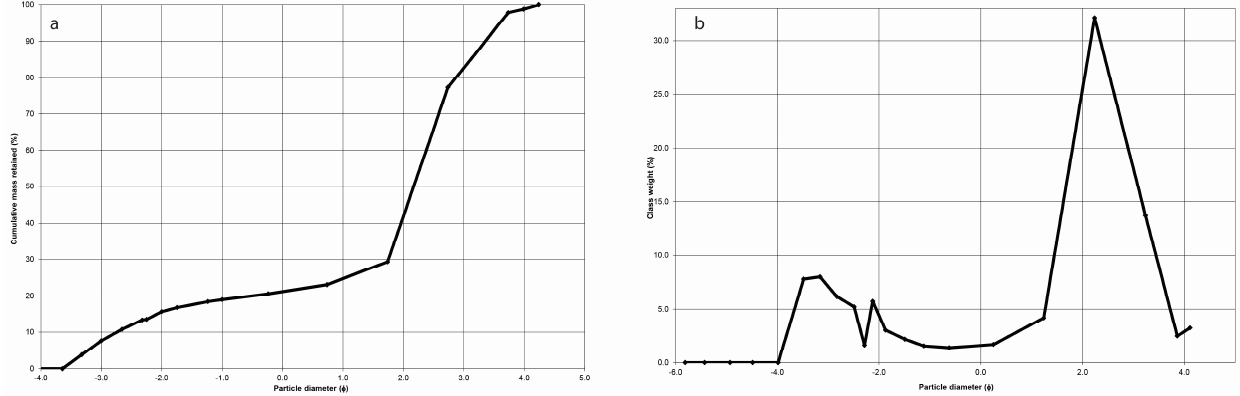
Figure 4. Cumulative (phi) and Distribution (phi) curves. ( a , b ) sample